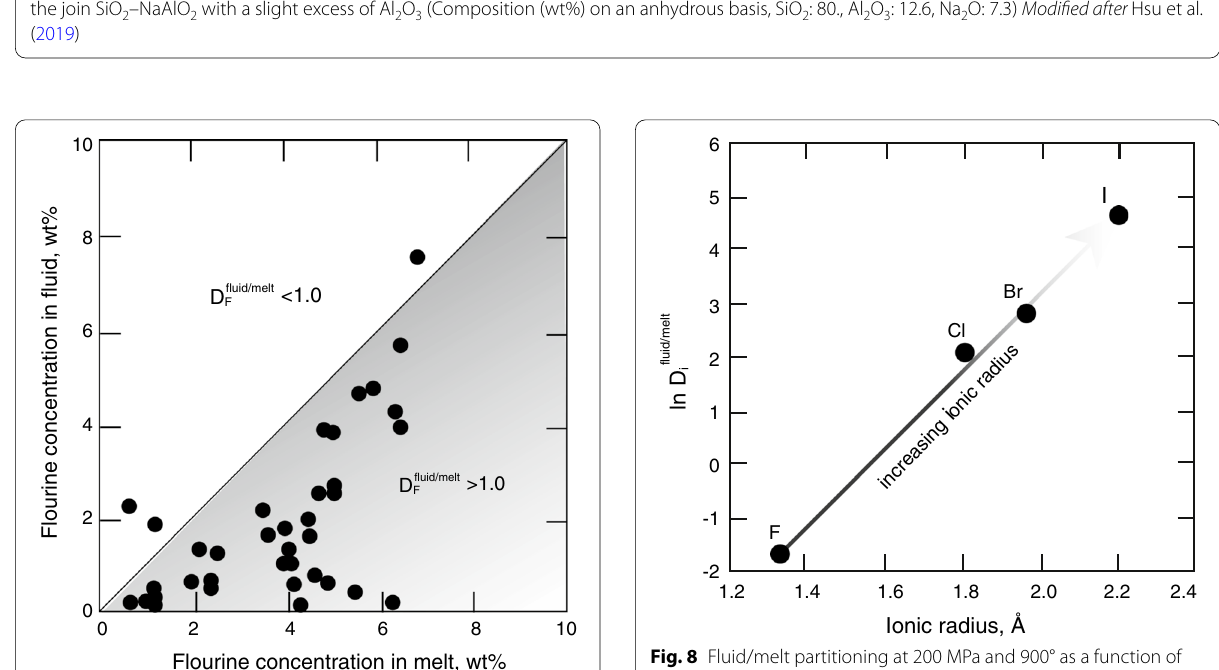
Fig. 6 Fluid/melt partition coefficient of chlorine, D fluid / melt indicated. B . D Cl